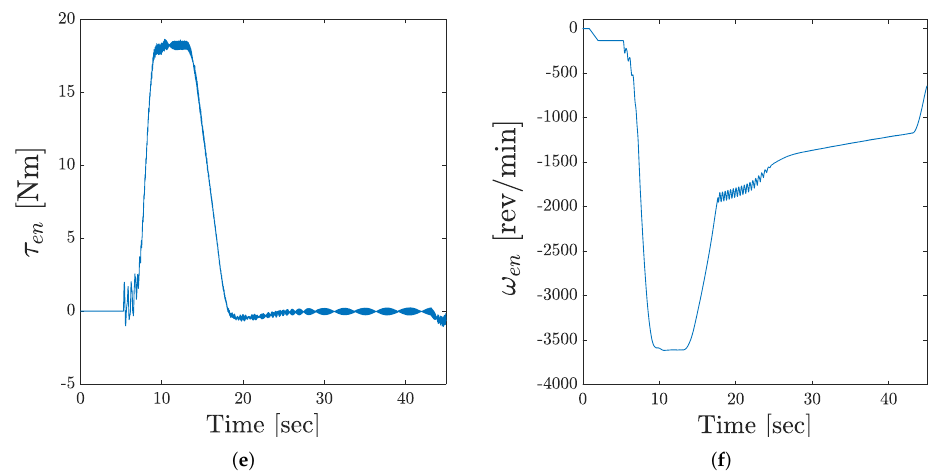
Figure 5. Indicative hybrid model responses, using the mean (nominal) values of Table 1: ( a ) angular velocity of the rear wheel, ( b ) braking torque of the rear wheel, ( c ) angular velocity of the transmission output shaft, ( d ) torque of the transmission output shaft, ( e ) torque of the engine and ( f ) angular velocity of the